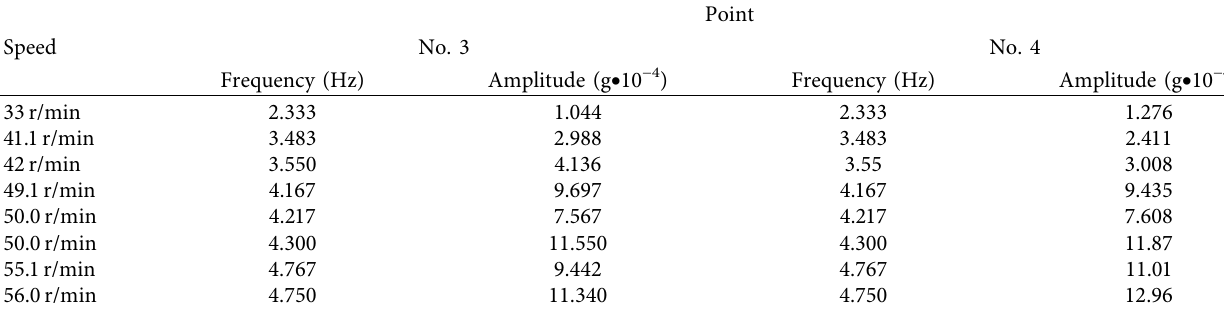
Table 3: Main data of hull longitudinal